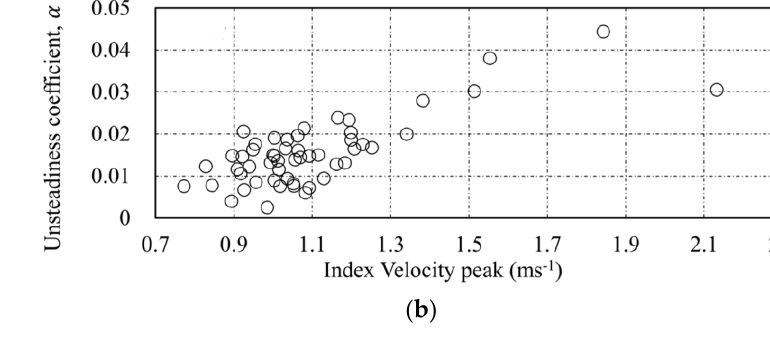
Figure 7. Introducing the pulse severity parameter: ( a ) terminology for defining stream variables’ response to hysteresis severity; and ( b ) summary of the index-velocity peak vs. severity of the individual pulses for the all the storm events in the analyzed dataset.